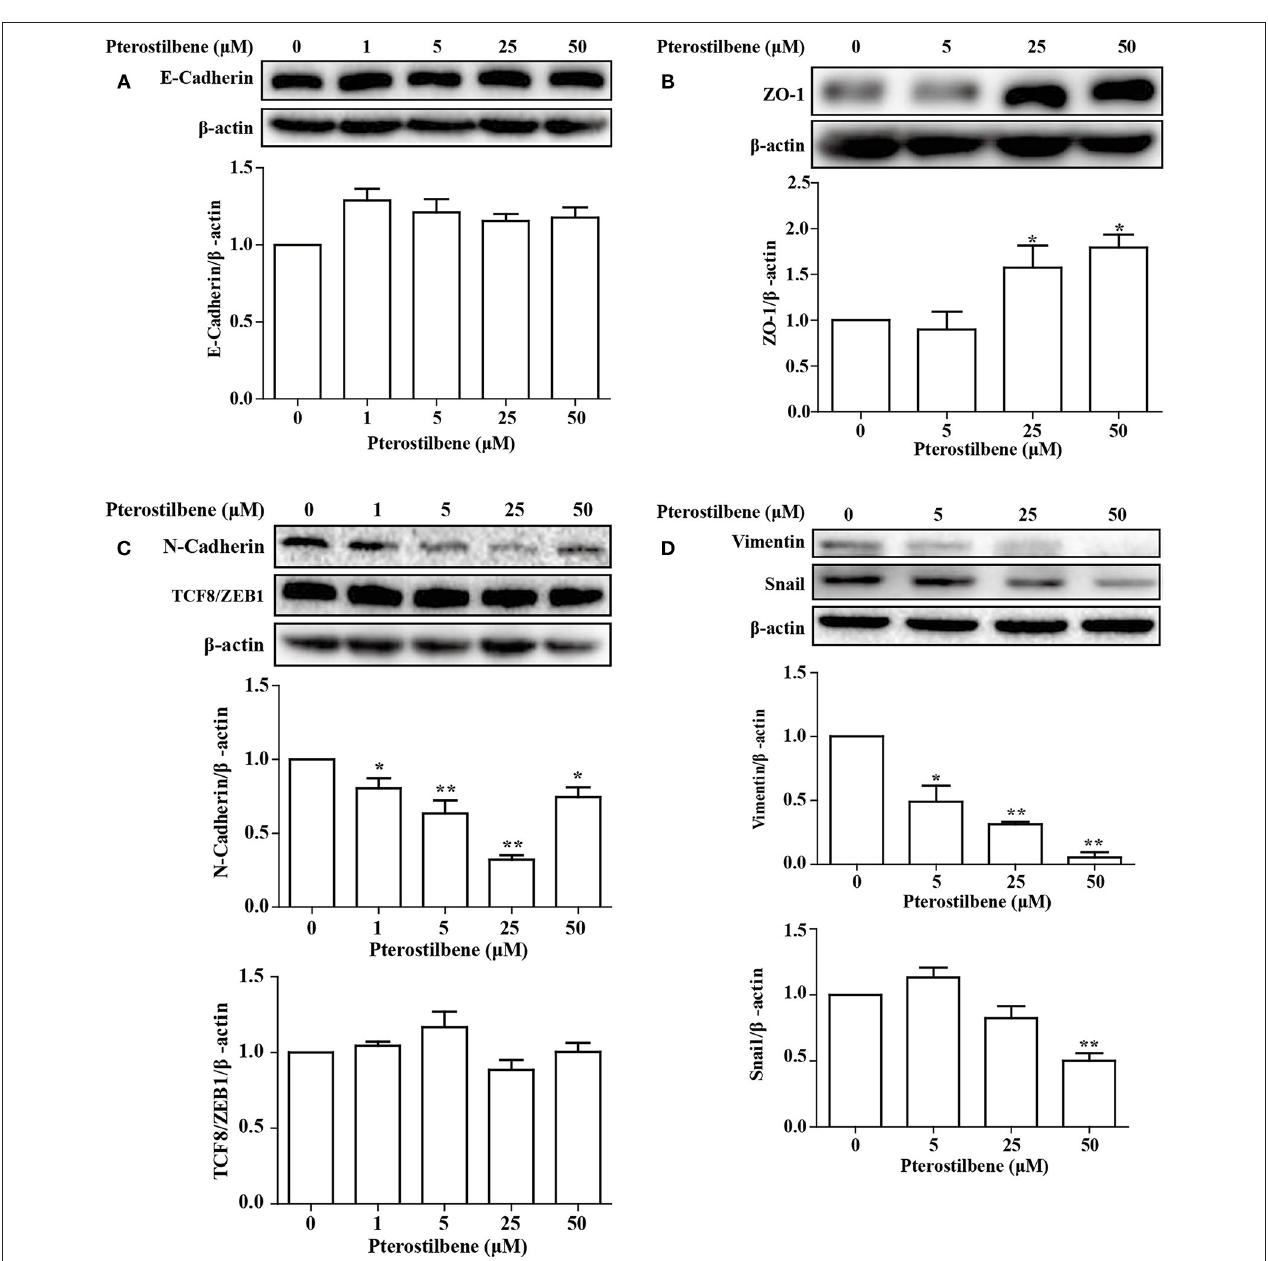
FIGURE 7 | Pterostilbene influenced expression of EMT-related genes ( A , E-cadherin; B , ZO-1; C , N-cadherin, and TCF8/ZEB1; D , Vimentin, and Snail). Gene expression in cells treated with pterostilbene at different concentrations for 24h was quantified by Western blot analysis. Reported values are mean ± SEM. * p < 0.05 and ** p < 0.01, indicate significant differences compared with the control